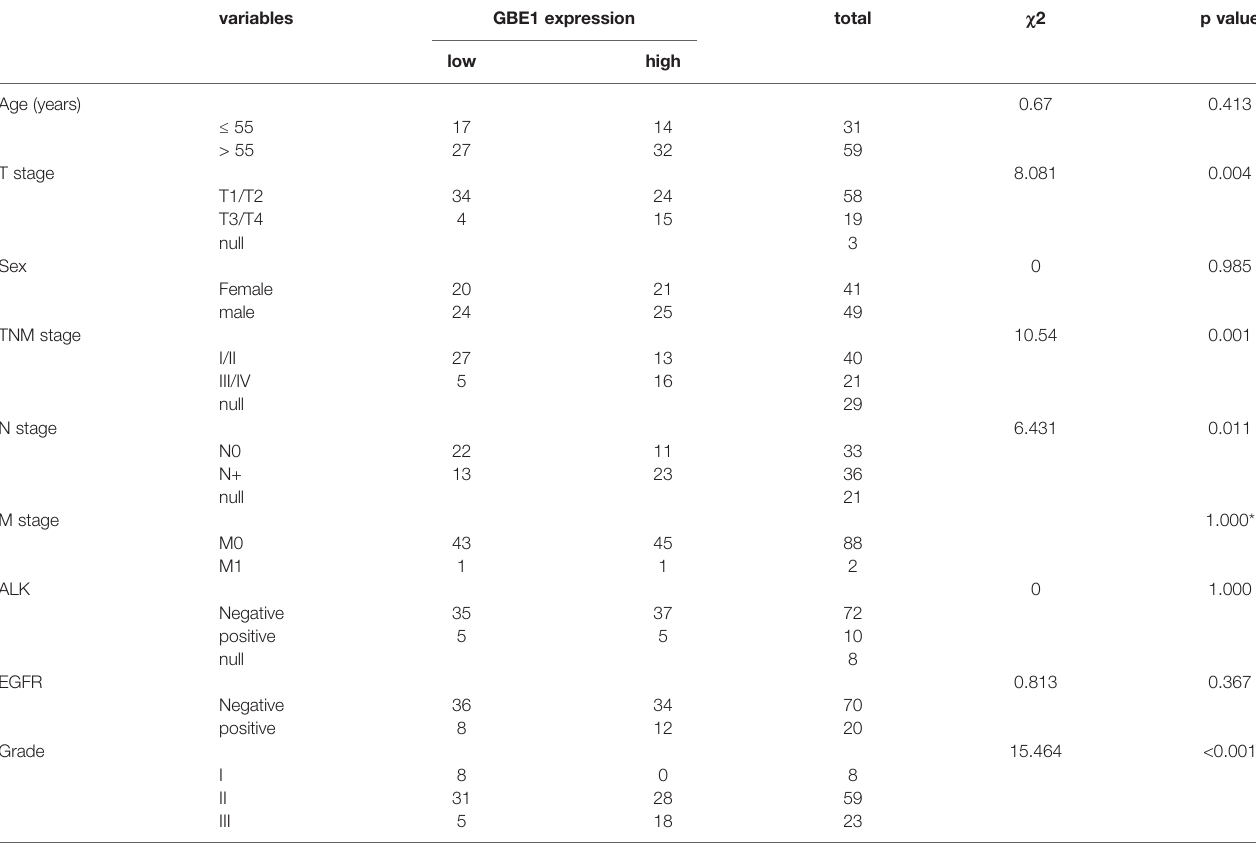
TABLE 2 | Correlation between GBE1 expression and clinicopathological characteristics in TMA cohort. variables GBE1